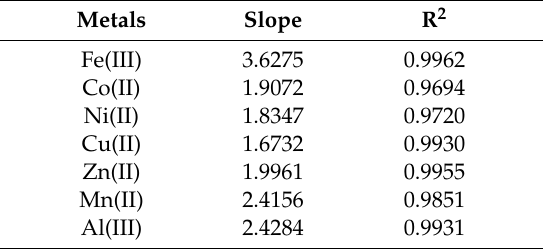
Table 2. Slope and the values of the regression coefficient for the initial linear section ([Me] in = 0–0.01